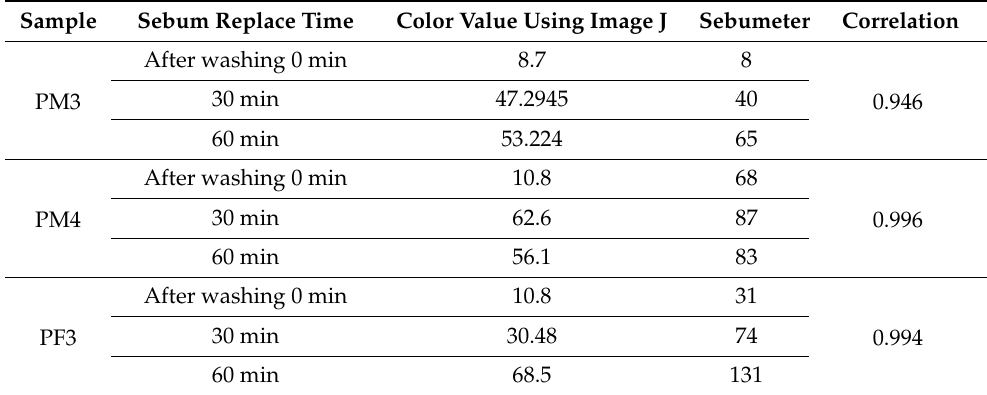
Table 2. Comparison of ORO-stained color intensity and results of Sebumeter ® on sebum replacement